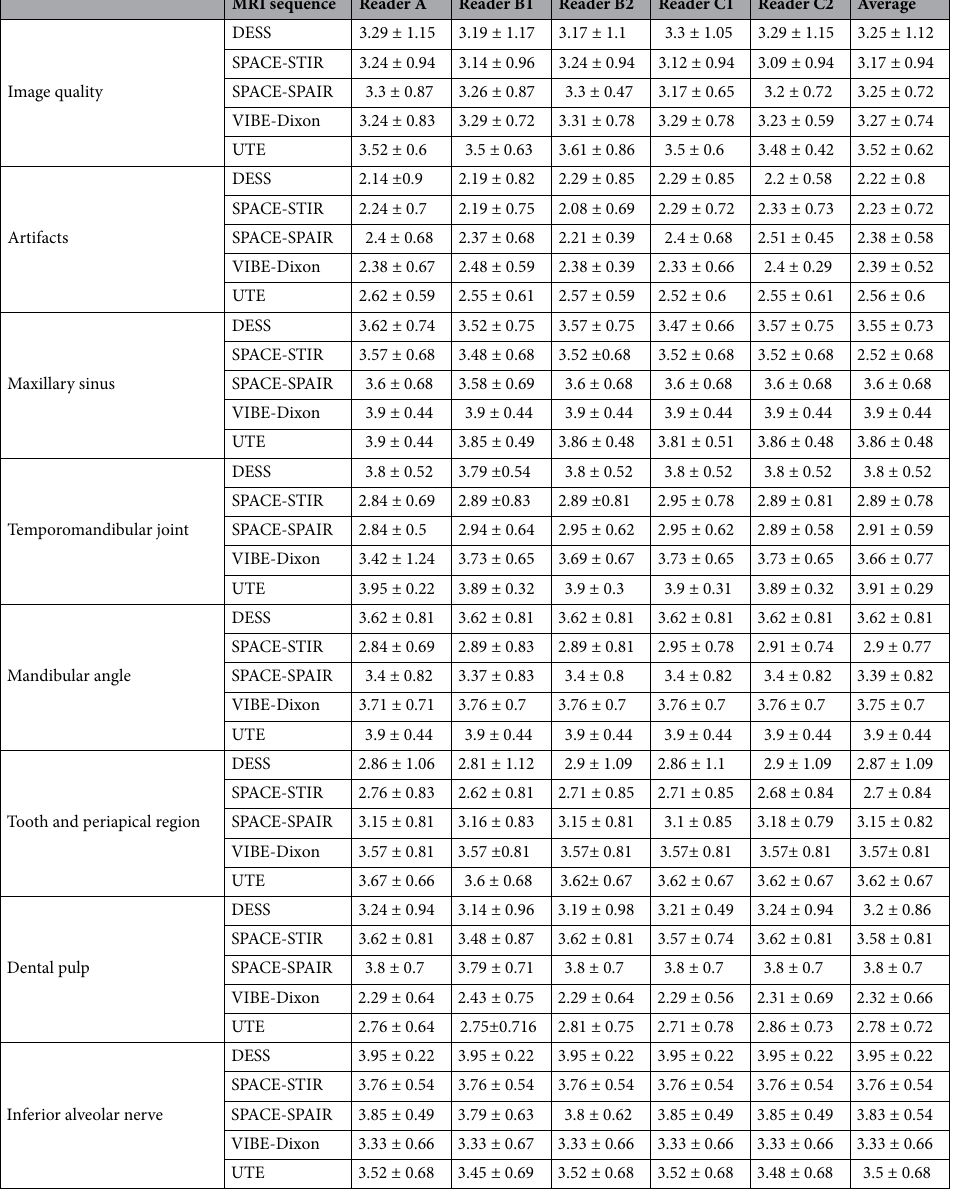
Table 3. Qualitative assessment of OPG (orthopantomogram) MRI reconstructions (MR-OPG’s) from the 3D double-echo steady-state (DESS), 3D fast spin echo short-tau inversion recovery (SPACE-STIR), 3D fast spin echo spectral attenuated inversion recovery (SPACE-SPAIR), 3D volumetric interpolated breath-hold examination (T1-VIBE-Dixon), and 3D ultrashort echo time (UTE) datasets were evaluated in randomized order by three readers with varying degrees of experience (reader A, attending board-certified oral surgeon; reader B, resident oral surgeon; reader C, attending board-certified radiologist and neuroradiologist). A modified Likert rating scale was used to evaluate overall technical image quality (4, excellent; 0, severely reduced image quality), assess artifacts (3, absence of artifacts; 0, massive artifacts), and evaluate visualization of specific anatomical structures in the oral cavity and surrounding skeletal structures relevant to OPG imaging (4, fine details are visible; 0; no structures are